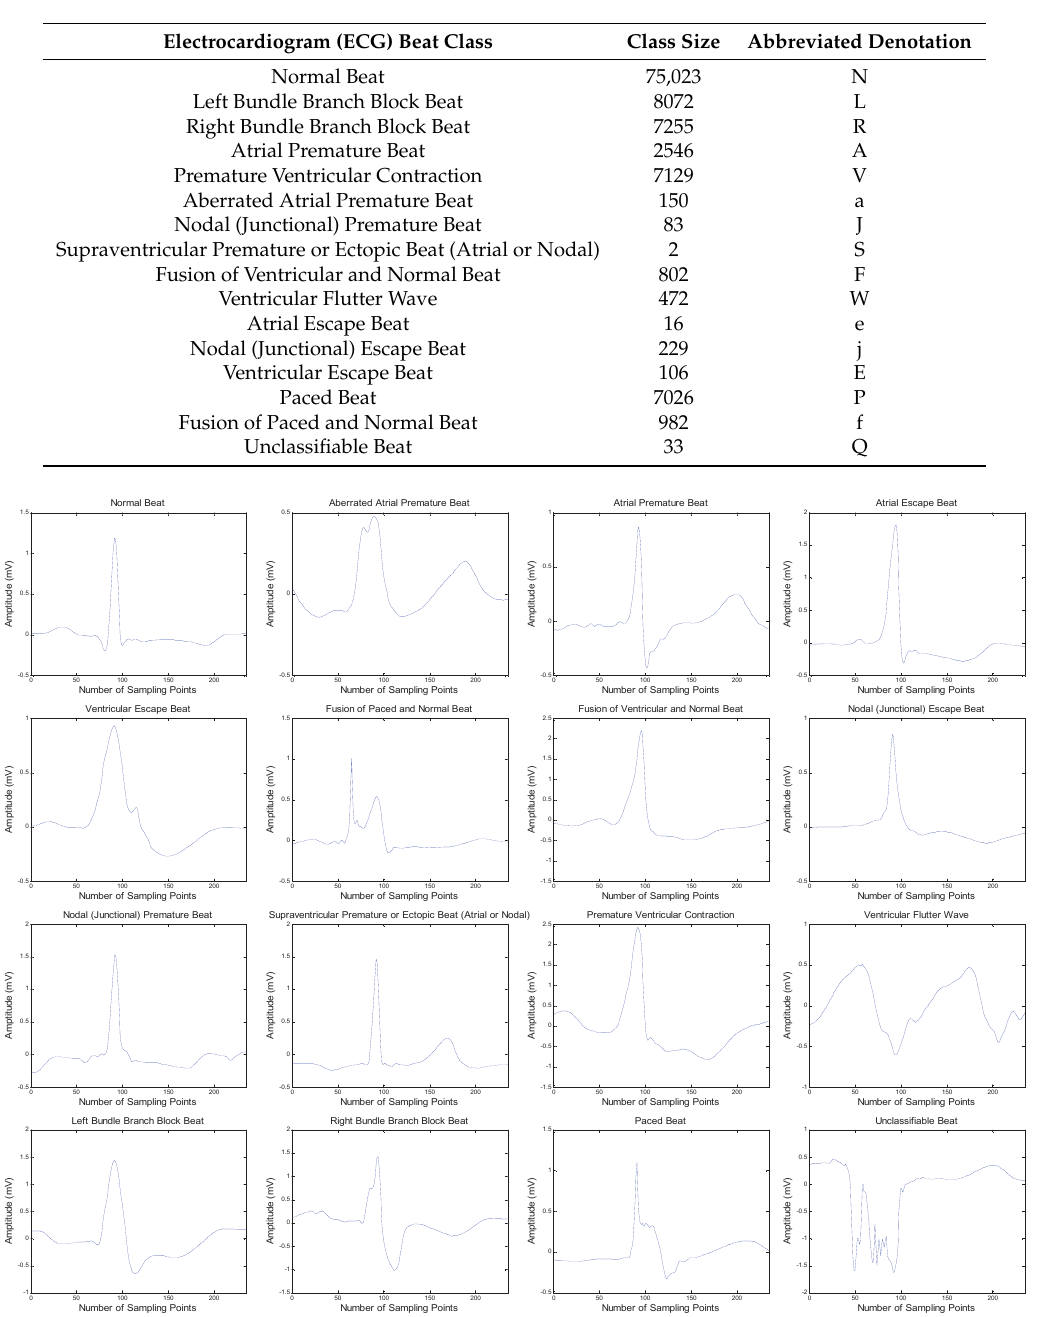
Figure 1. Illustration of 16 types of electrocardiogram (ECG)